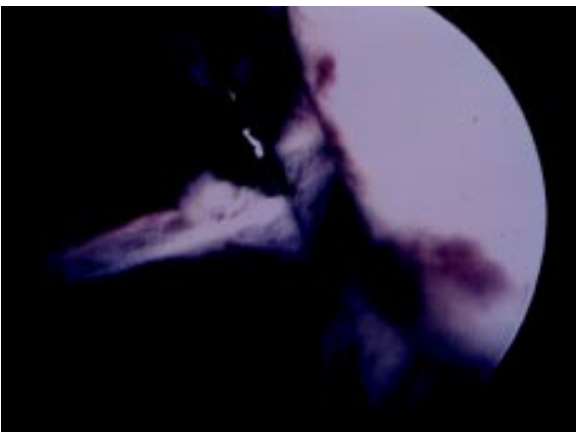
Figure 7 - Cutting